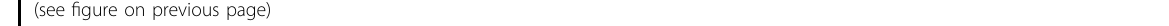
Fig. 1 Effect of Plg-R KT de fi ciency on burn wound healing. A Quanti fi cation of the remaining wound area at different time points after wounding of male Plg-R KT − / − mice ( ● ) and Plg-R KT + / + littermates ( ○ ) ( n = 6). The mixed-effects model (REML), showed a signi fi cant effect for time ( p < 0.0001, f = 396.6), and for genotype ( p = 0.040, f = 6.00) and a signi fi cant time × genotype interaction ( p < 0.0001, f = 4.289). Post hoc testing was done with two-tailed t tests at each time point * p < 0.05. B Scab loss data are shown for a cohort of Plg-R KT + / + mice ( n = 6) and a cohort of Plg-R KT − / − littermates ( n = 5). p = 0.019, Χ 2 = 5.465, d f = 1 by the log-rank (Mantel – Cox) test. C Representative images of H&E-stained slides of Plg-R KT − / − and Plg-R KT + / + wound tissue on the day indicated after wounding. The leading edges of the epithelial layer (epithelial tongues) are indicated by open arrows, the epidermal layer is indicated by closed arrows, and the scabs are indicated with asterisks. (On day 4 following wounding, no epidermis was present.) Scale bar = 200 µm. D Quanti fi cation of data shown in panel C for the area of the tongue at day 4 after wounding. By Mann – Whitney test: Plg-R KT + / + (Mdn = 42,984), Plg-R KT − / − (Mdn = 33,212), ( U = 15, p = 0.28 2 n = 8 Plg-R KT + / + mice and n = 6 Plg-R KT − / − mice. E Quanti fi cation of data shown in panel C for epidermal thickness before and at day 20 after wounding. Data analysis by robust ANOVA showed a trend for the effect of genotype ( p = 0.058, f = 4.24), and a trend for the effect of burn treatment ( p = 0.077, f = 3.655) and a burn treatment× genotype interaction ( p